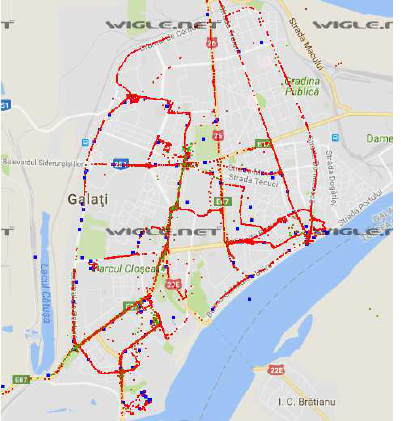
Figure 2. Wardrive results in Galati